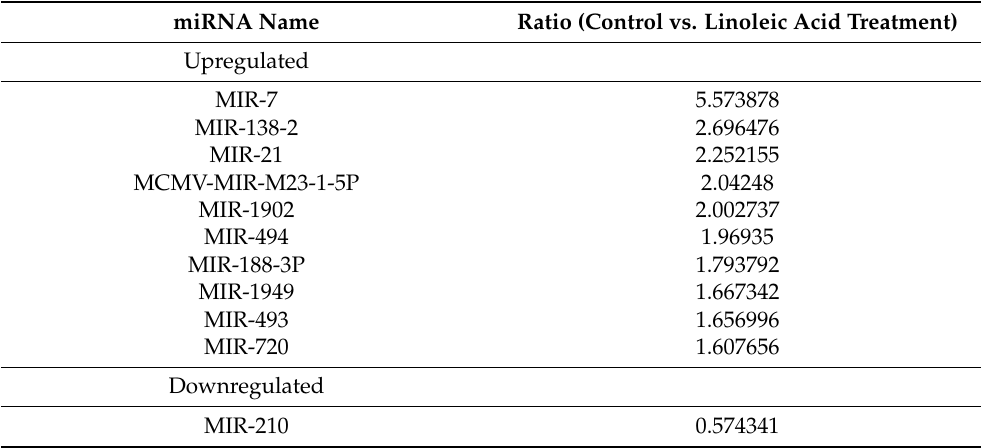
Table 1. Altered microRNA expression in linoleic acid-treated CT26